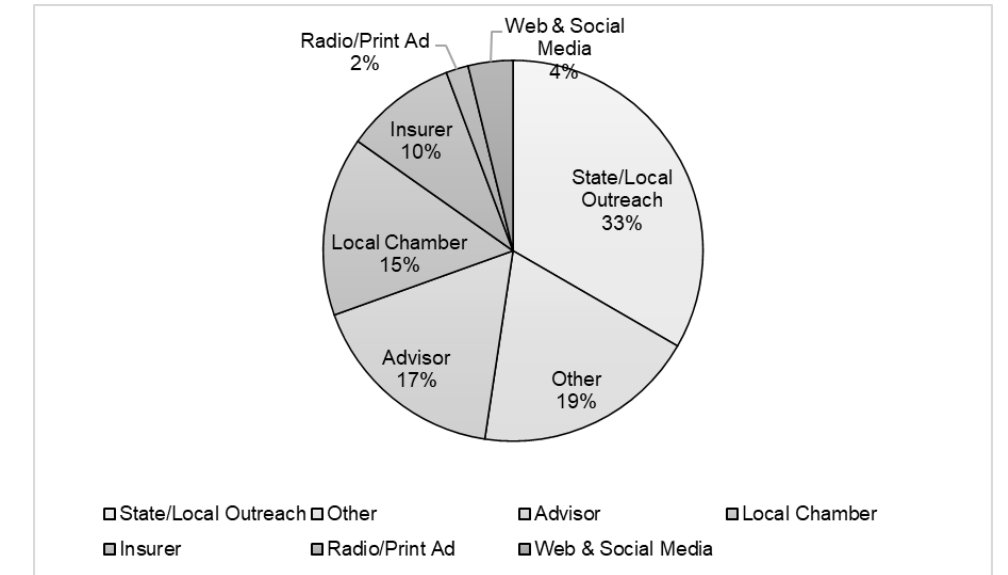
Figure 2. Primary sources of dissemination indicated by Health Links enrolled users. “How did you hear about Health Links?” .